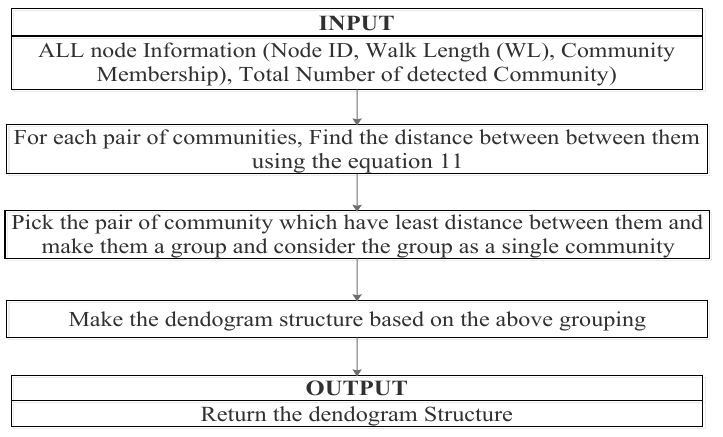
Figure 2. The process of developing dendogram structure to identify